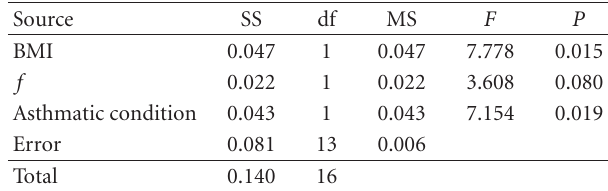
Table 6: Analysis of covariance for total deposited fraction by asthmatic